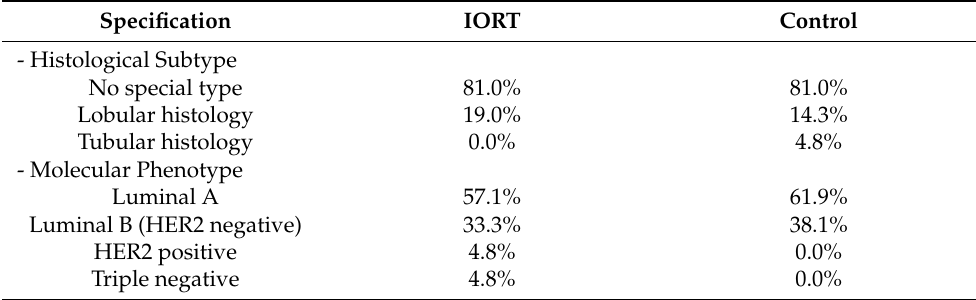
Table 1. Distribution of histological subtypes and histological phenotypes in the tissue samples from patients of IORT and control group, n = 42 (IORT 21, control